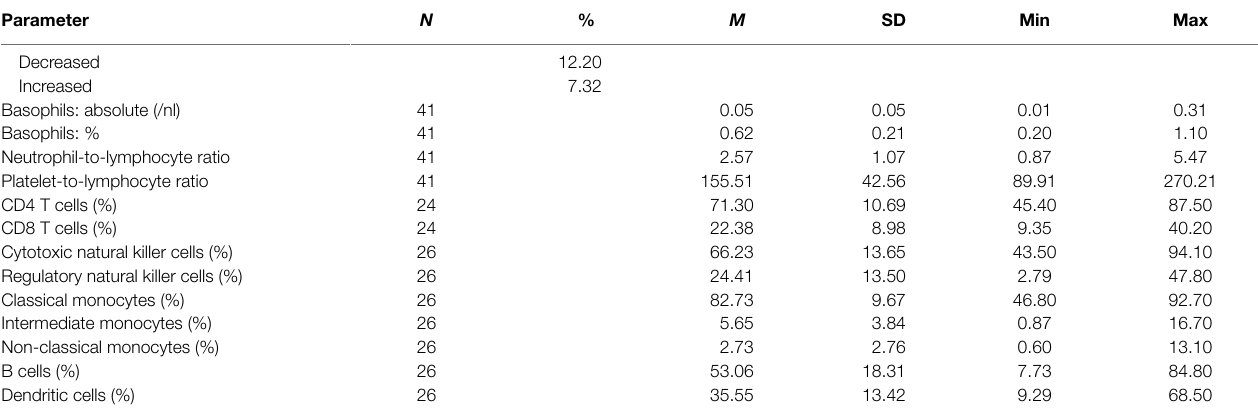
Correlations Between Lifestyle Factors, Psychological Factors, Audiological Factors, Immune Cell Subsets, and Other Blood Parameters Correlations between lifestyle factors, psychological factors, audiological factors, immune cell subsets, and other blood parameters are shown in Figure 2 . Significant correlations between psychological factors and immune cell subsets were observed for: THI scores and NKc cell frequency, r = − 0.42, p = 0.037 ( n = 25); PSQ-20 and NKc cell frequency, r = − 0.44, p = 0.028 ( n = 25); and PSQ-20 scores and dendritic cell frequency, r = − 0.42, p = 0.039 ( n = 25). No significant correlations between audiological factors and immune cell subsets were present. Regarding other investigated blood parameters (fibrinogen, HDL cholesterol, LDL cholesterol, ferritin, CRP, IL-1b, IL-6, TNF- α , VEGF, IGF-1, NLR, PLR), no correlations with psychological factors were present. With audiological factors, correlations were found for: hearing threshold and TNF- α levels, r = − 0.34, p = 0.028 ( n = 41); tinnitus loudness (SL) and TNF- α levels, r = − 0.53, p = 0.002 ( n = 32); tinnitus loudness (SL) and IL-1b levels, r = 0.35, p = 0.047 ( n = 32); tinnitus loudness (SL) and IGF-1 levels, r = − 0.46, p = 0.008 ( n = 32); loudness discomfort level and HDL cholesterol levels, r = − 0.37, p = 0.019 ( n = 39); loudness discomfort level and ferritin levels, r = 0.47, p = 0.002 ( n = 39); loudness discomfort level and PLR, r = − 0.35, p = 0.023 ( n = 41); ABR wave I latency and VEGF levels; r = − 0.40, p = 0.020 ( n = 34); and ABR wave V latency and ferritin levels, r = 0.35, p = 0.030 ( n = 38). Network Analysis: Averaged